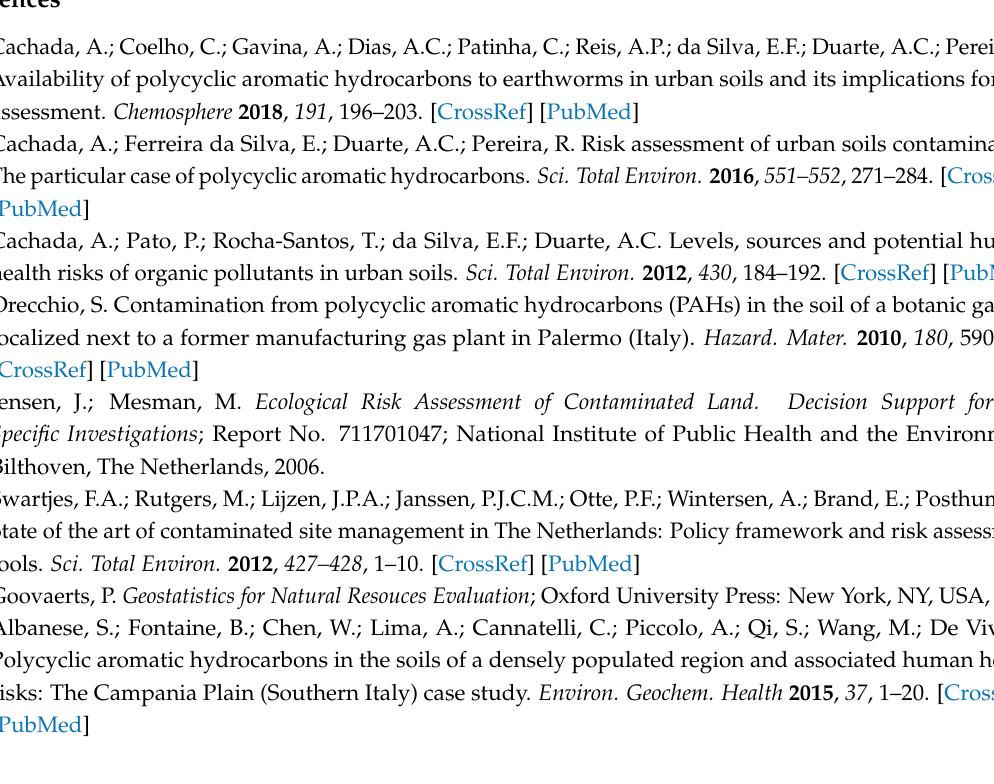
Figure S1: Boxplot showing the variation of the Sum16PAHs in Lisbon soils. Boxes define the interquartile range and the line is the median. Outliers are defined as values between 1.5 and 3 box lengths (o) and extreme values as more than 3 box lengths (x); Figure S2: Median percentages of individual compounds in Lisbon urban soils; Figure S3: Loading plots of factor 1 and factor 2 of the FA including PAHs and PTEs; Figure S4: Toxic pressure of the PAHs mixture (TPm) for the 97 samples from Lisbon, considering different guidelines values; Table S1: Descriptive statistics of the general physical and chemical parameters of Lisbon urban soils; Table S2: Descriptive statistics of potentially toxic elements’ concentrations in Lisbon urban